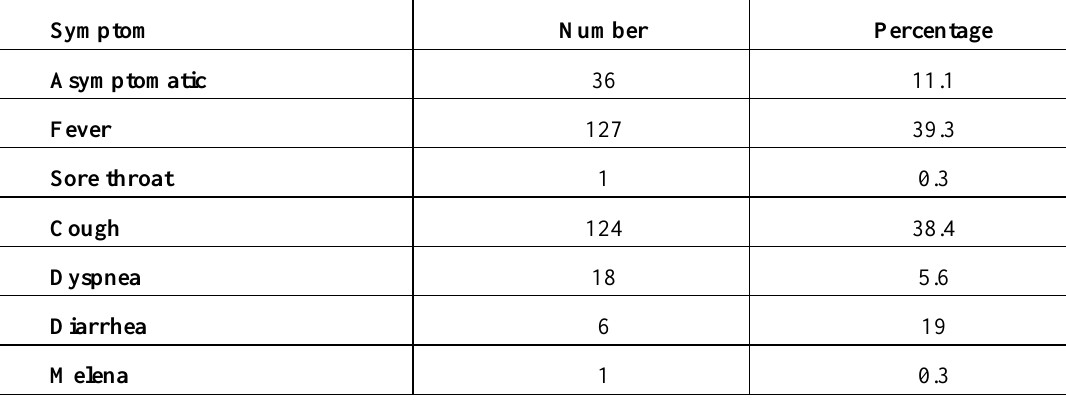
Table 1. Presenting symptoms of admitted COVID-19 patients at Ain Shams University Hospitals (n=323).